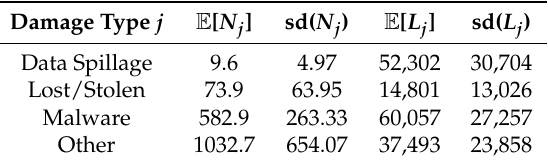
Table 7. The averages and standard deviations of the frequency and total losses for each different type of damage. This table shows in particular how the assumptions on the cost of an incident map to costs over a three month